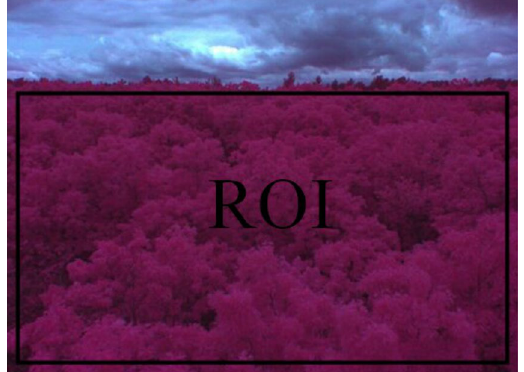
Figure 6. The example of an infrared image on September 19 th , 2014. The black rectangles indicate the Region of Interest (ROI) used to calculate camera-NDVI. The ROI includes approximately 2,800,000 pixels. Because plants absorb much red light and reflect a lot of infrared light, this NDVI camera makes near infrared wavelengths visible as red while red wavelengths appear as green and green as blue, and thus produced a new color-infrared (CIR) image. On CIR imagery vegetation appears